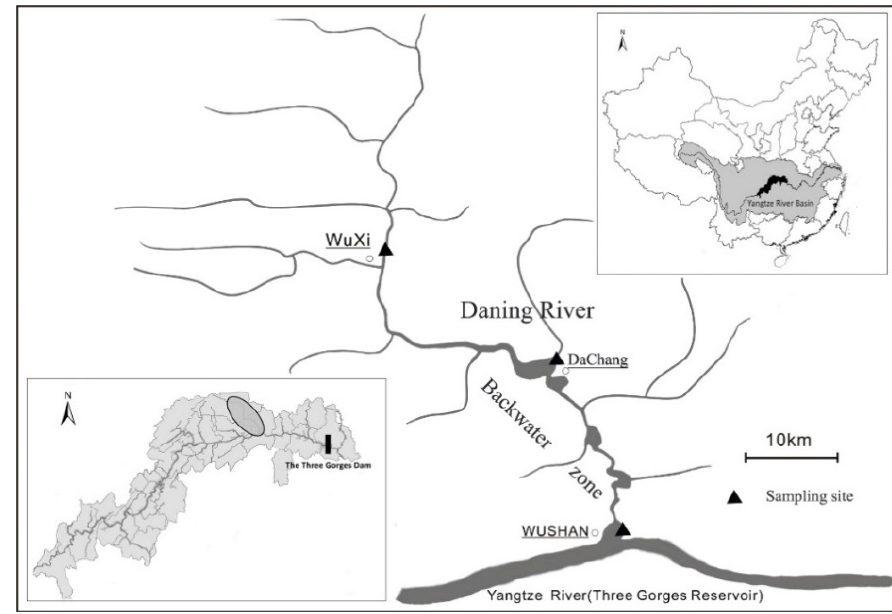
Figure 1. The location of the Three Gorges Reservoir Region and the sampling sites in the Daning River.